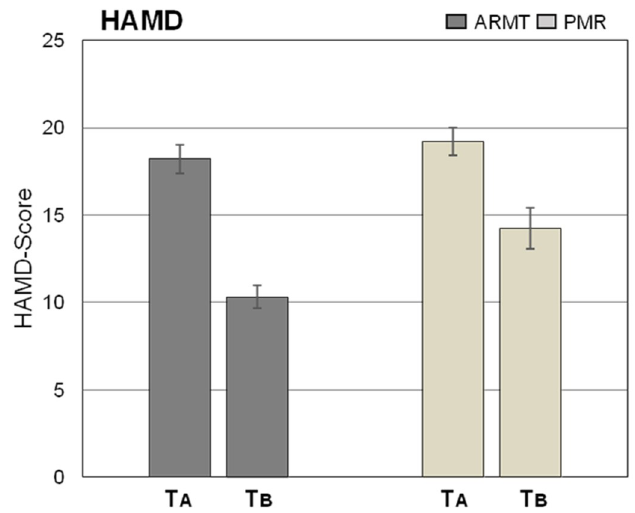
Figure 2. Summed up Hamilton Depression Scale (HAMD) scores in ARMT and PMR groups before ( T A ) and after ( T B ) completing the full series of treatments (mean ±